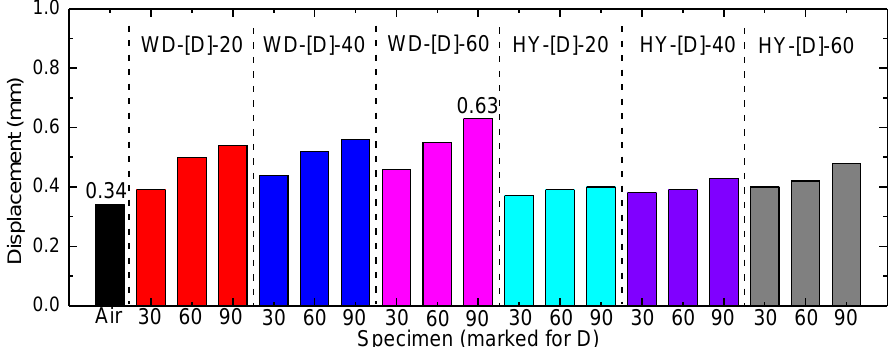
Figure 8. Displacements of each specimen under 10 kN.